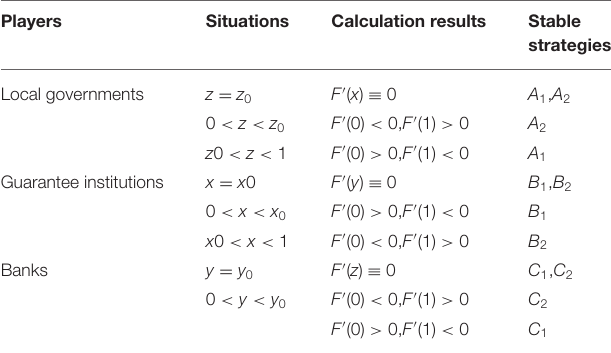
TABLE 2 | Evolutionary stability results of three players’ strategies. Players Situations Calculation results Stable